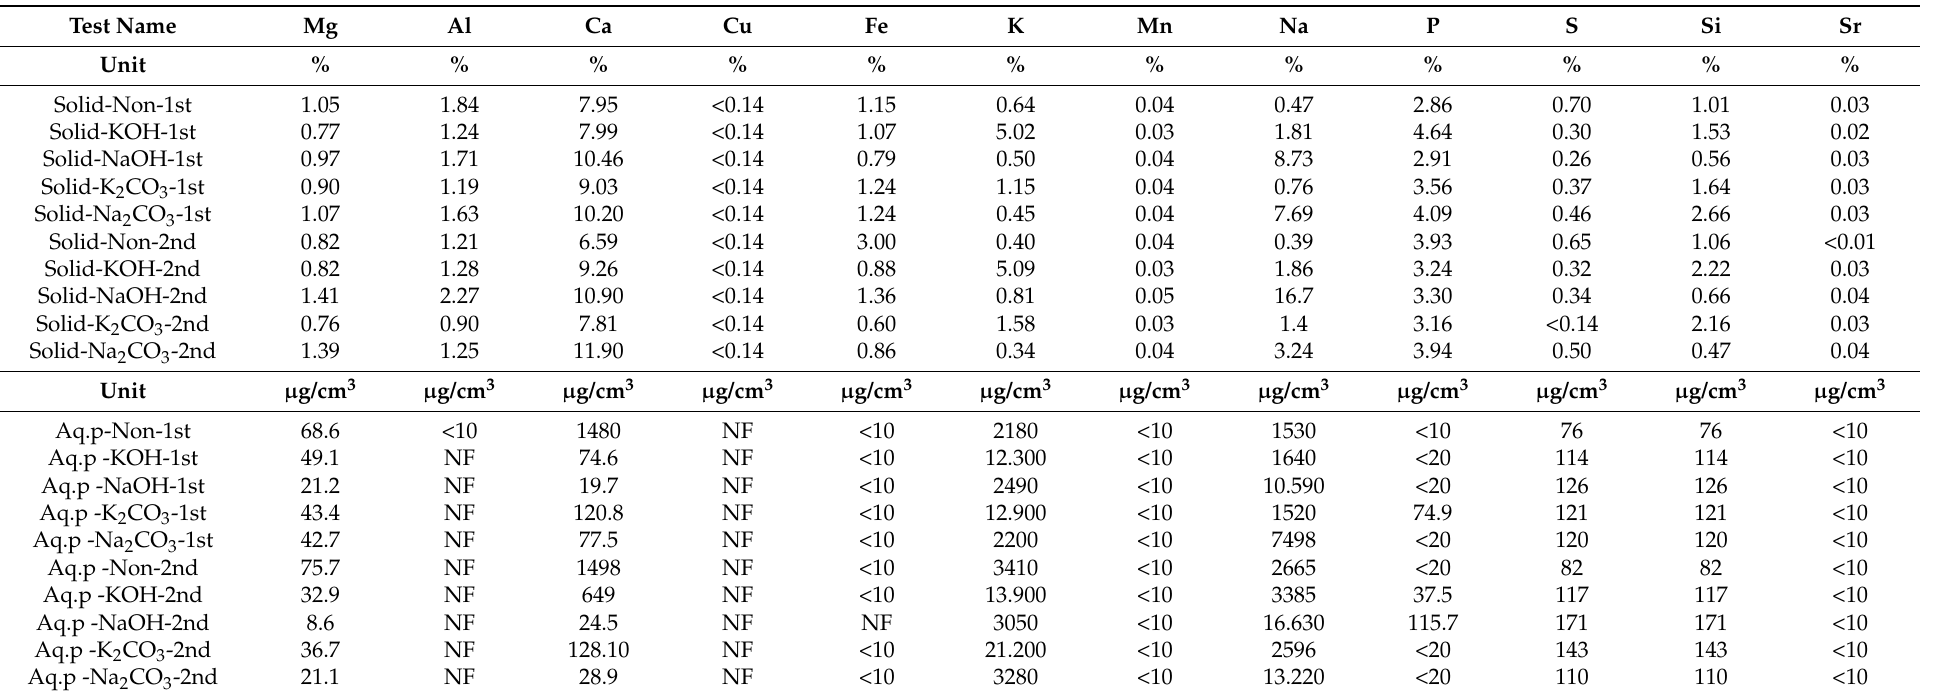
Table 4. ICP results of solid residue and aqueous phase samples obtained from